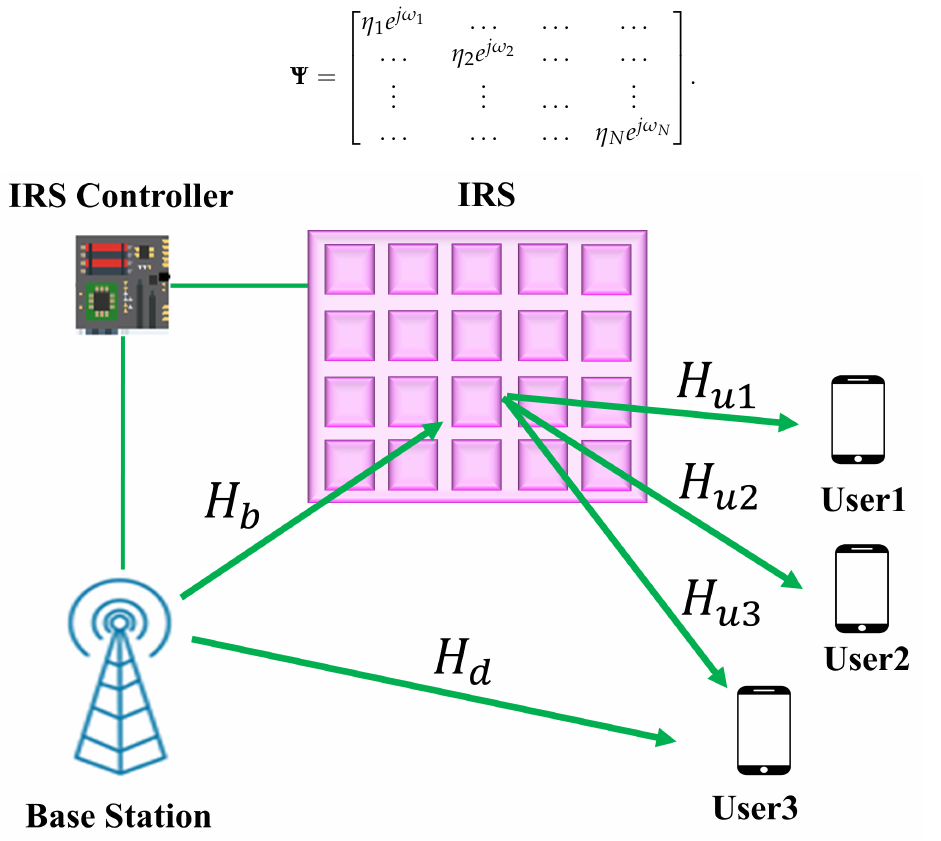
Figure 1. Intelligent reflecting surface in the multiuser MIMO communication